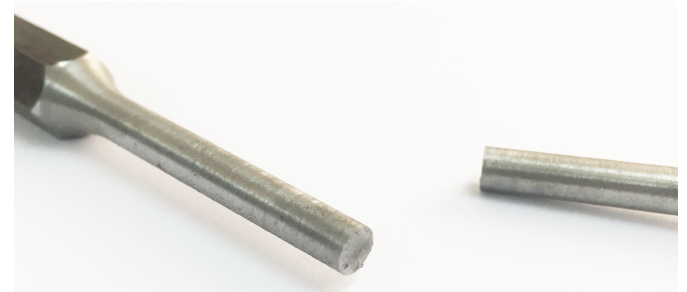
Figure 4. Failure condition of the torsion sample.